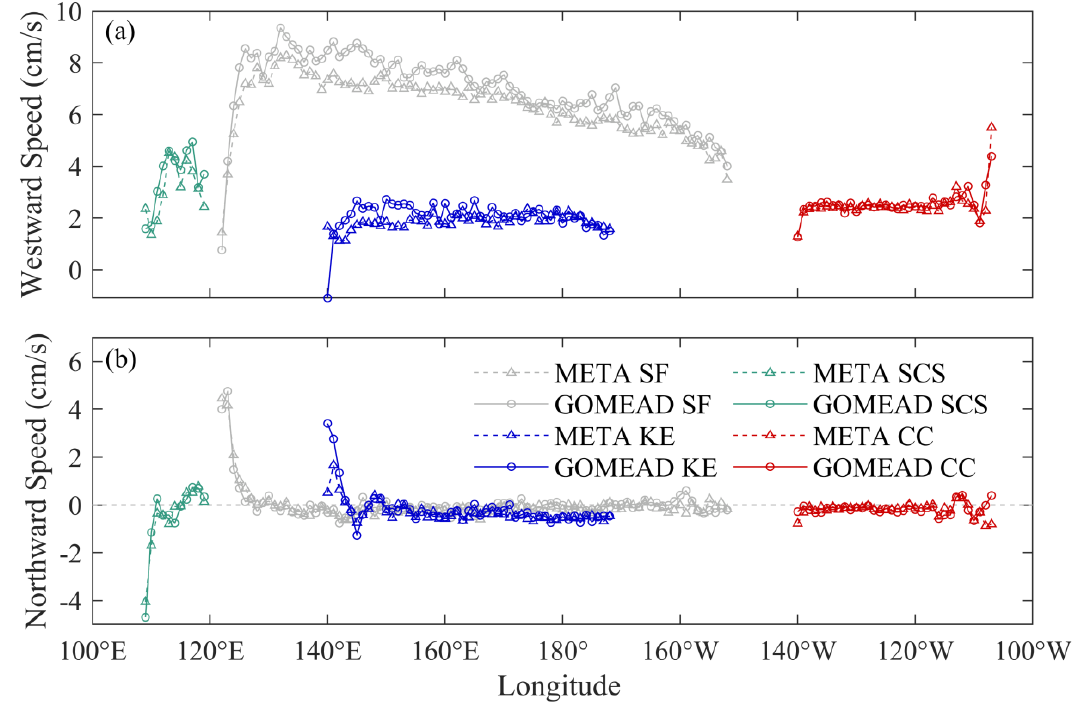
Figure 17. Same as Figure 16, but for CEs. Figure 17. Variations of ( a ) westwards and ( b ) northwards speeds of CEs by longitude. Dashed and solid curves represent the META and GOMEAD datasets, respectively. Figure 17. Variations of (a) westwards and (b) northwards speeds of CEs by longitude. Dashed and 530 solid curves represent the META and GOMEAD datasets, respectively.